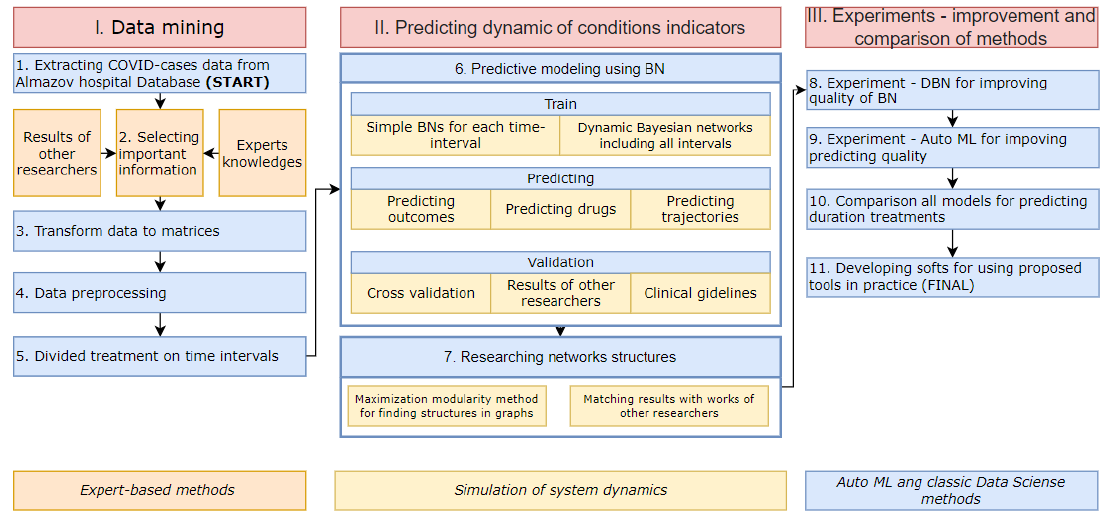
Figure 1. Procedure. Research includes 3 stages and 11 steps.